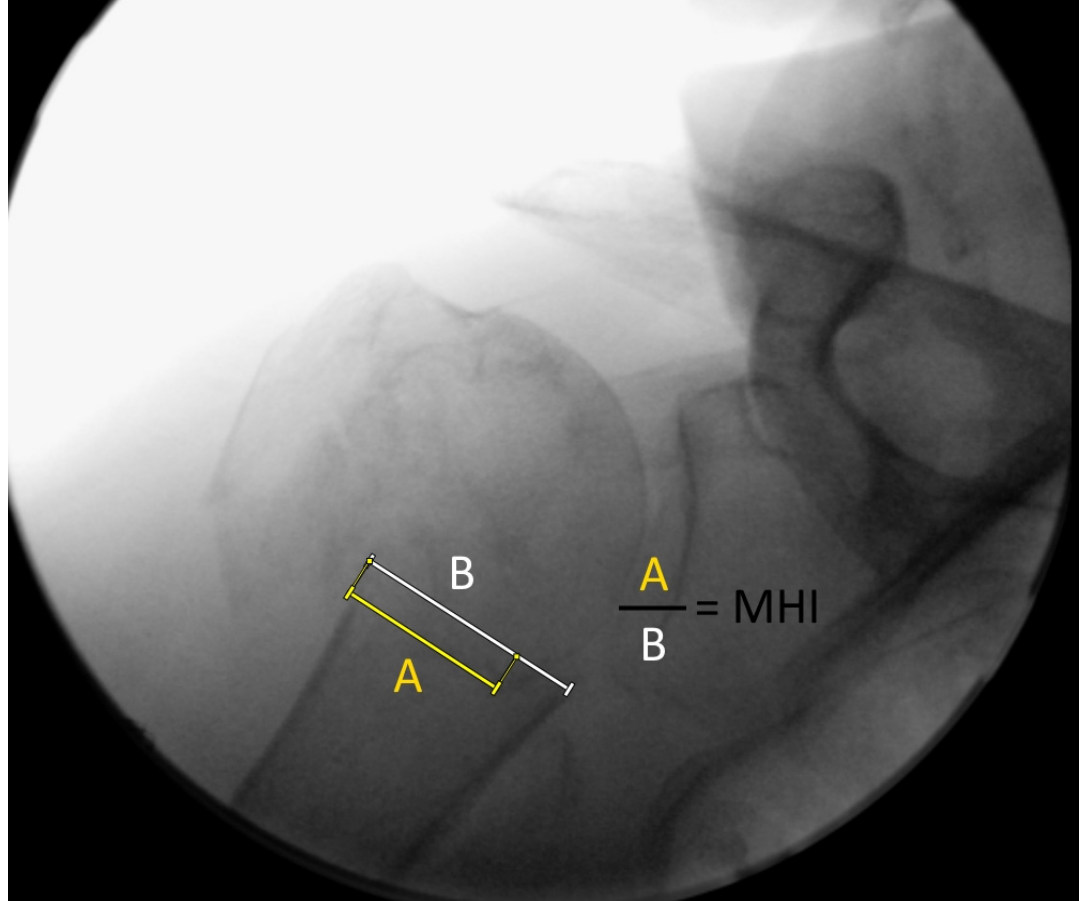
Figure 3. Fluoroscopic measurement of the medial hinge index (MHI). ‘A’ is defined as a line from the most proximal and lateral point of the humeral shaft to the most medial humeral head articular surface. ‘B’ is defined as a line from the most proximal and lateral point to the most proximal and medial point of the humeral shaft.